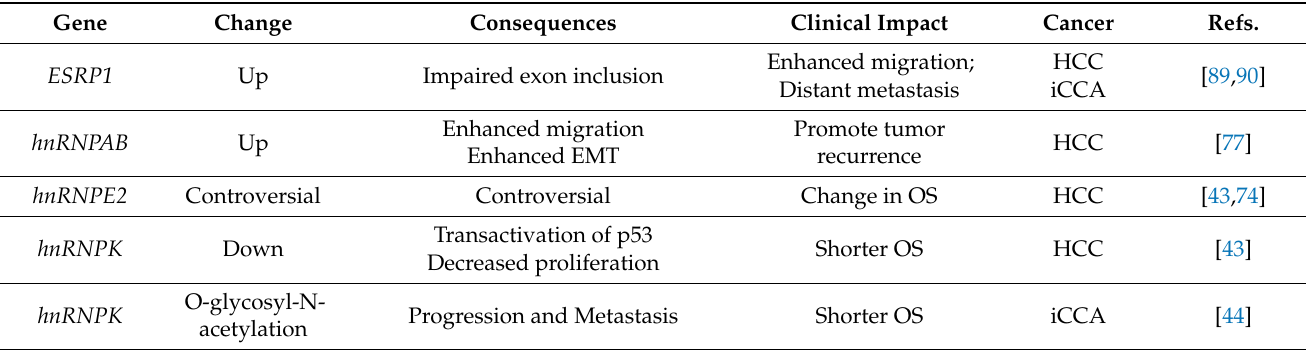
Table 1. Impact of altered expression of spliceosome components and associated regulating proteins on the outcome of patients with liver